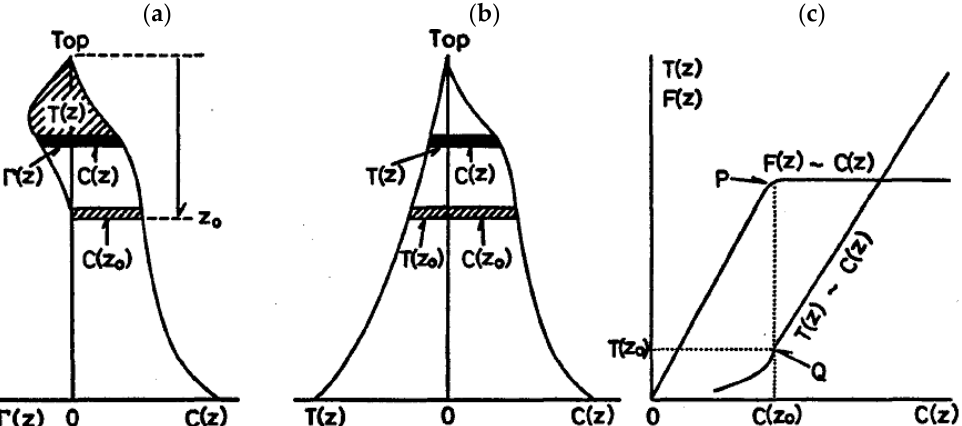
Figure 1. Concept of the statical model of plant form as an extension of the pipe model theory (PMT) to tall trees (Oohata and Shinozaki, 1979) [25] (Figure 2). ( a ) Vertical profiles of leaf and woody mass per length. ( b ) Vertical profiles of cumulative total (leaf and woody) mass from the top and woody mass per length. ( c ) Relationship between cumulative leaf/total mass from the top and woody mass per length. Γ and C are the leaf and woody mass per length at distance z from the treetop, respectively; F and T are the cumulative leaf and total mass from the treetop, respectively; and z 0 is the crown length at which the crown and trunk are divided.